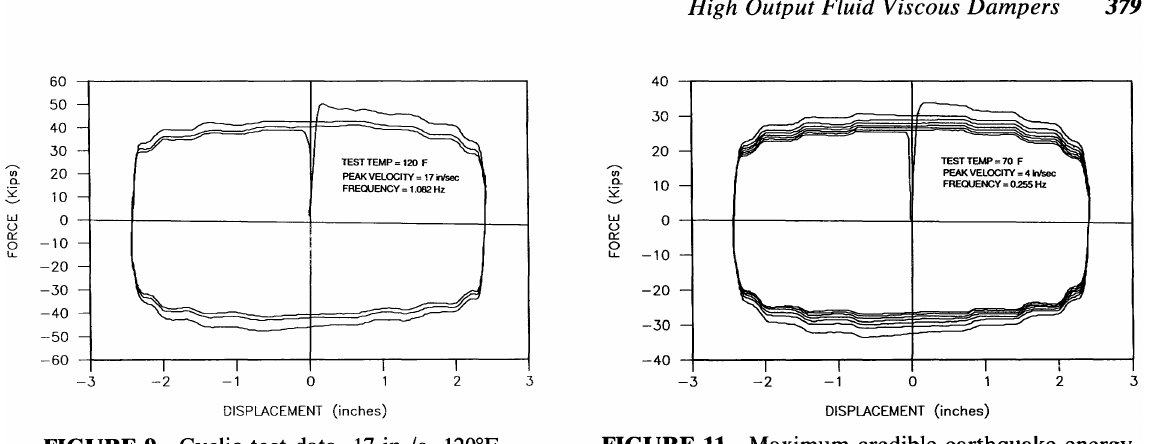
FIGURE 11 Maximum credible earthquake energy. uation, these being +70, +120, and +32°F. Pa rameter drift for the damper was minimal over the entire range tested. Figure 13 plots comparative cyclic test and drop test data on the scaled prototype damper. The 70°F cyclic test results were used as a func tional baseline, with a curve fitted to the test data and an allowable correlation band width of ± 10%, represented in Fig. 13 by dashed lines. All drop test points were well within the allowable band width, demonstrating the comparative results from the two test methods. Figure 14 plots test results from a series of drop tests at speeds to 60 in./s and forces to the 300 kip level. All points plot within the acceptance band for the full sized device.